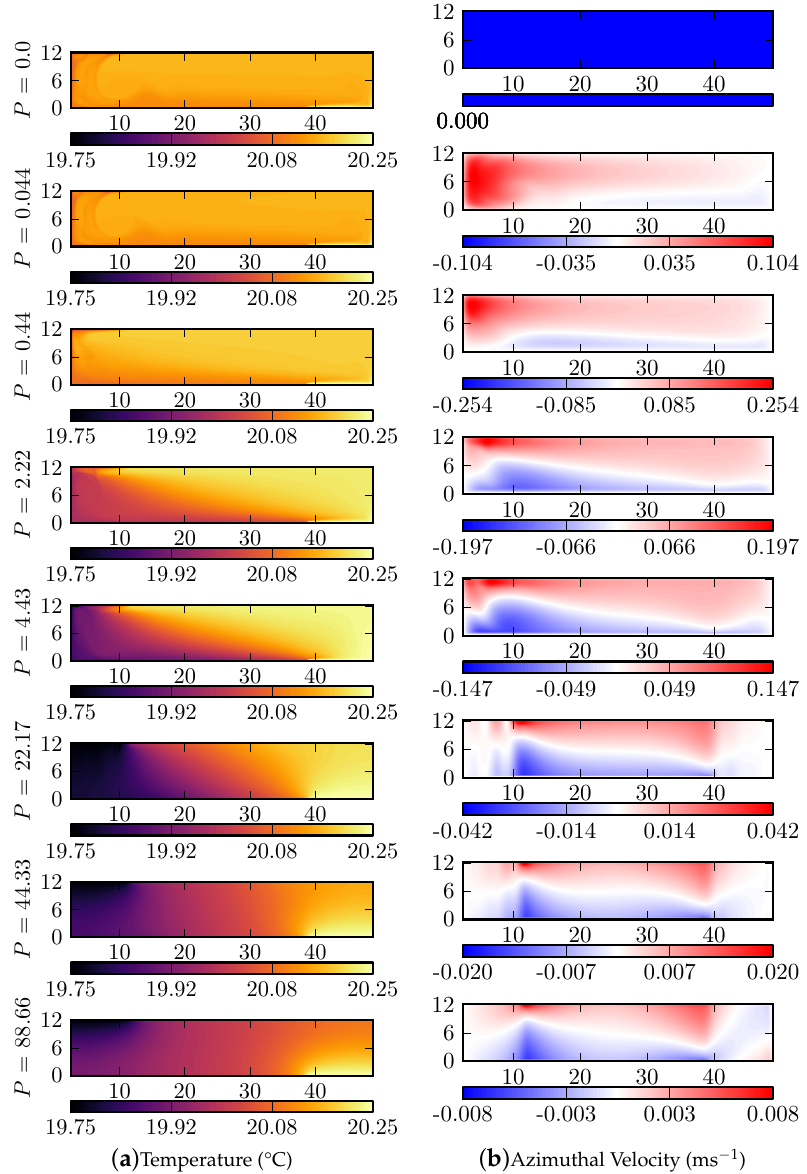
Figure 5. ( a ) r , z cross-sections of the equilibrated, time averaged temperature field for ∆ T = 0.5 °C, d = 12.2 cm and the full range of rotation rates. The value of P for each run is shown on the left hand side. These correspond to rotation rates of 0, 0.001, 0.01, 0.05, 0.1, 0.5, 1 and 2 rad cross-sections of the equilibrated, time averaged azimuthal velocity fields for the same